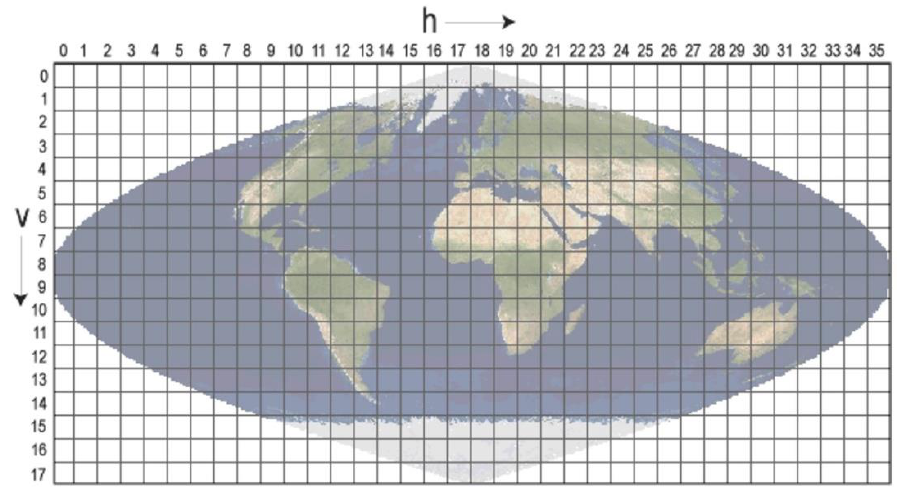
Figure 4. MODIS sinusoidal tile grid consisting of 460 non-overlapping tiles, and each tile covers approximately 10° × 10°.